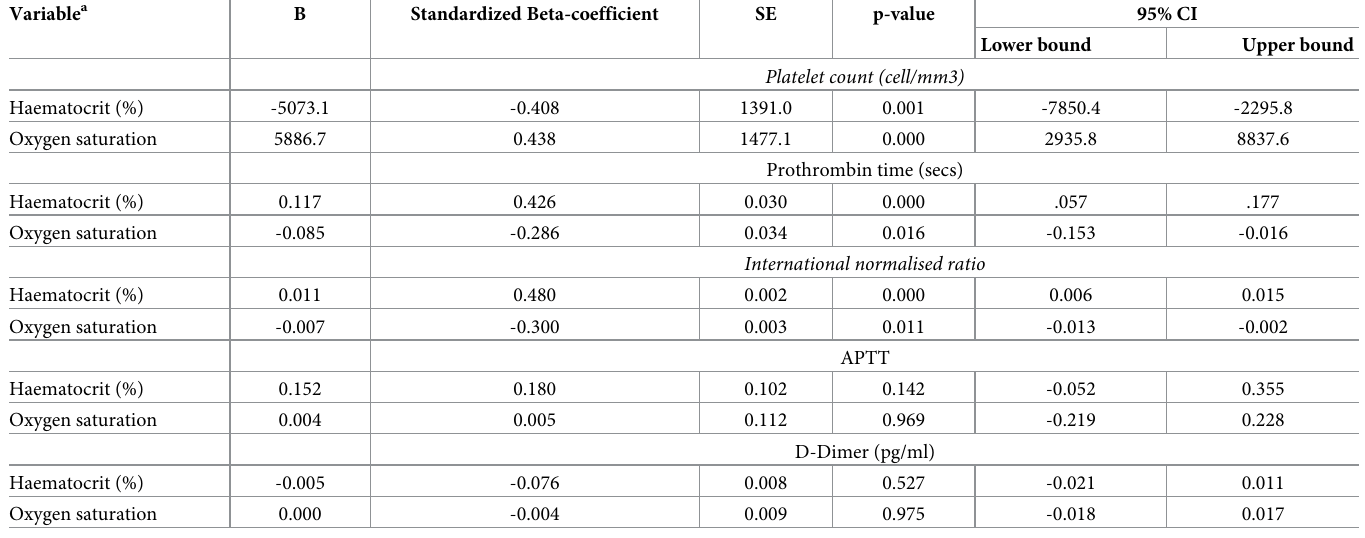
Table 9. Multivariate logistic analysis of significant variables and coagulation